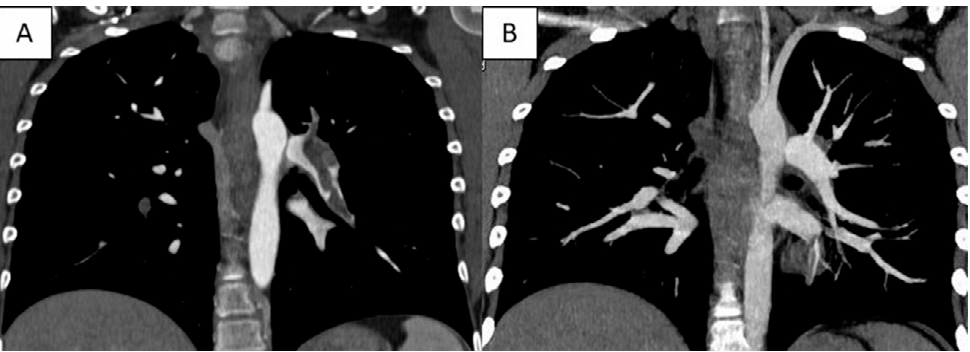
Figure 1. ( A ) Computed tomographic angiography of the lungs showing bilateral pulmonary em- bolism: on the right occluding the distal tract of the main branch with extension to the lobar, middle and lower branches; on the left, fluctuating in the main branch with extension to the lobar, upper and lower branches. ( B ) Computed tomographic angiography of the lungs showing resolution of pulmonary embolism.